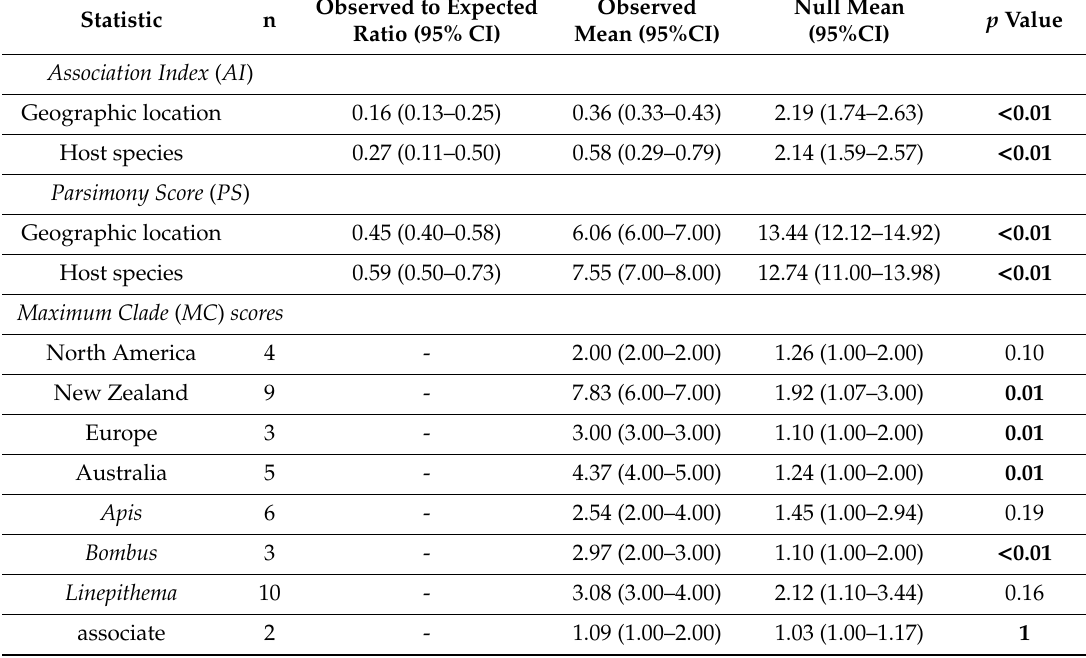
Table 4. Trait–tip associations for Kashmir bee virus (KBV), as calculated with 500 random trees (replicates) in BaTS (Bayesian tip-association significance testing) [52]. Significant p values are in bold font. Low parsimony score represents fewer state changes on the tree and stronger trait-tip association. Maximum clade scores show the maximum size of a clade for a trait state; a high MC is positively correlated with trait–tip association. The geographic regions of Asia of South America were only represented by one sample each and are not